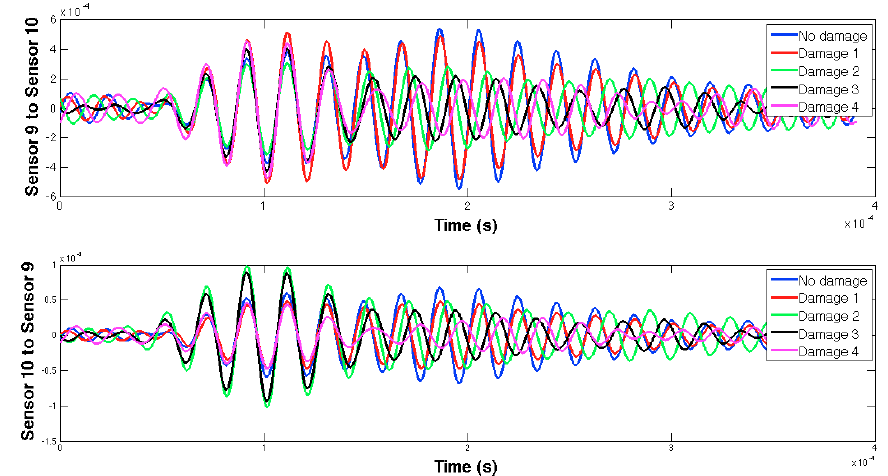
Figure 27. EMPD at 50 kHz. Tone-burst sent and measured between sensors 9 and 10.